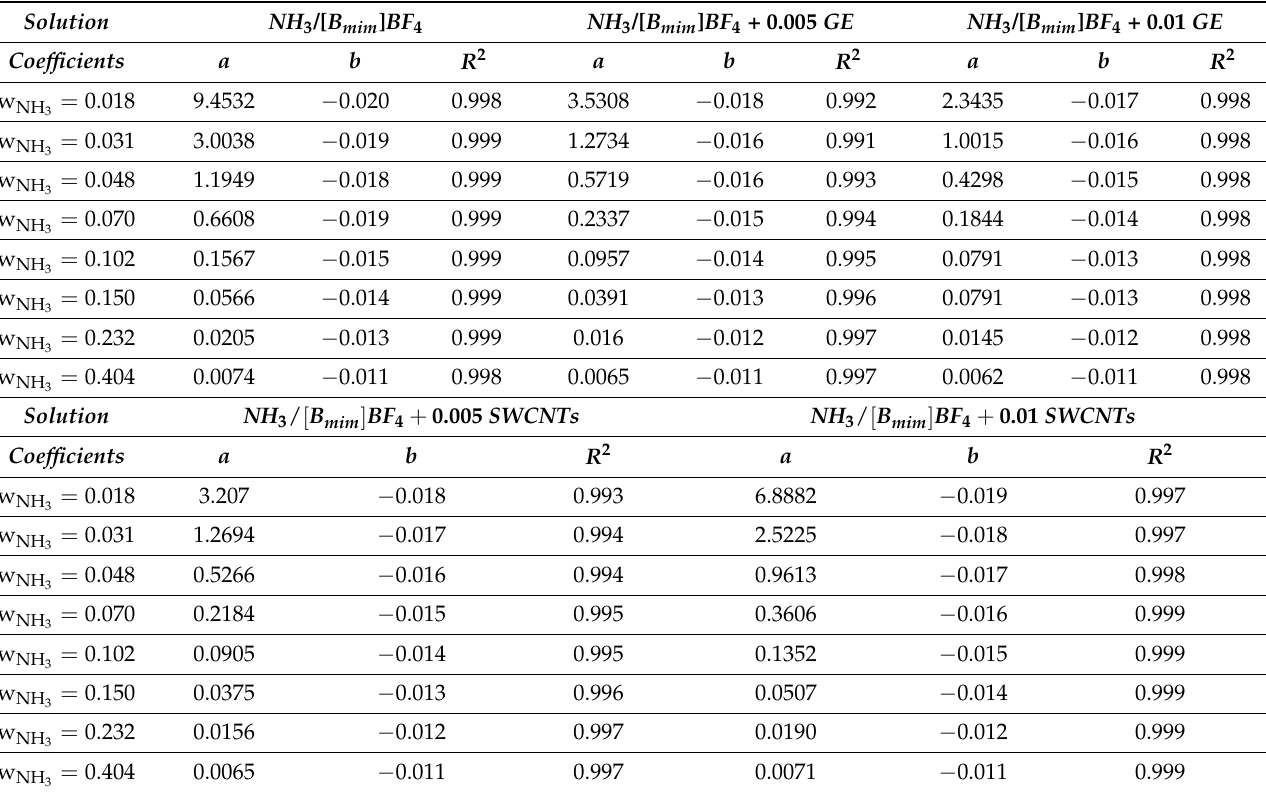
The coefficient values 𝑎 , 𝑏 , and 𝑅 (cid:2870) are given in Table 5. Table 5. Coefficient values 𝑎 , 𝑏 , and 𝑅 (cid:2870) obtained by fitting Equation (5).